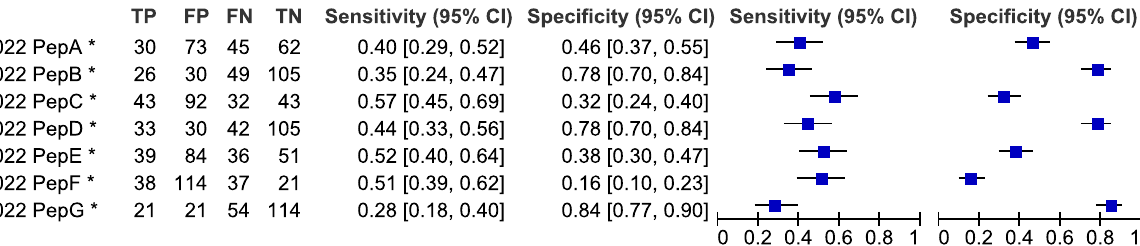
Figure 5. Forest plot representing percentage of sensitivity and speci fi city of different peptide-based tests for both visceral leishmaniasis (VL) and tegumentary leishmaniasis (TL) diagnosis. * studies where the counts of true positive (TP), false positive (FP), false negative (FN), and true negative (TN) results were estimated from the sensitivity and speci fi city values. # studies where sensitivity and speci fi city were recalculated considering all non-cases in a single control